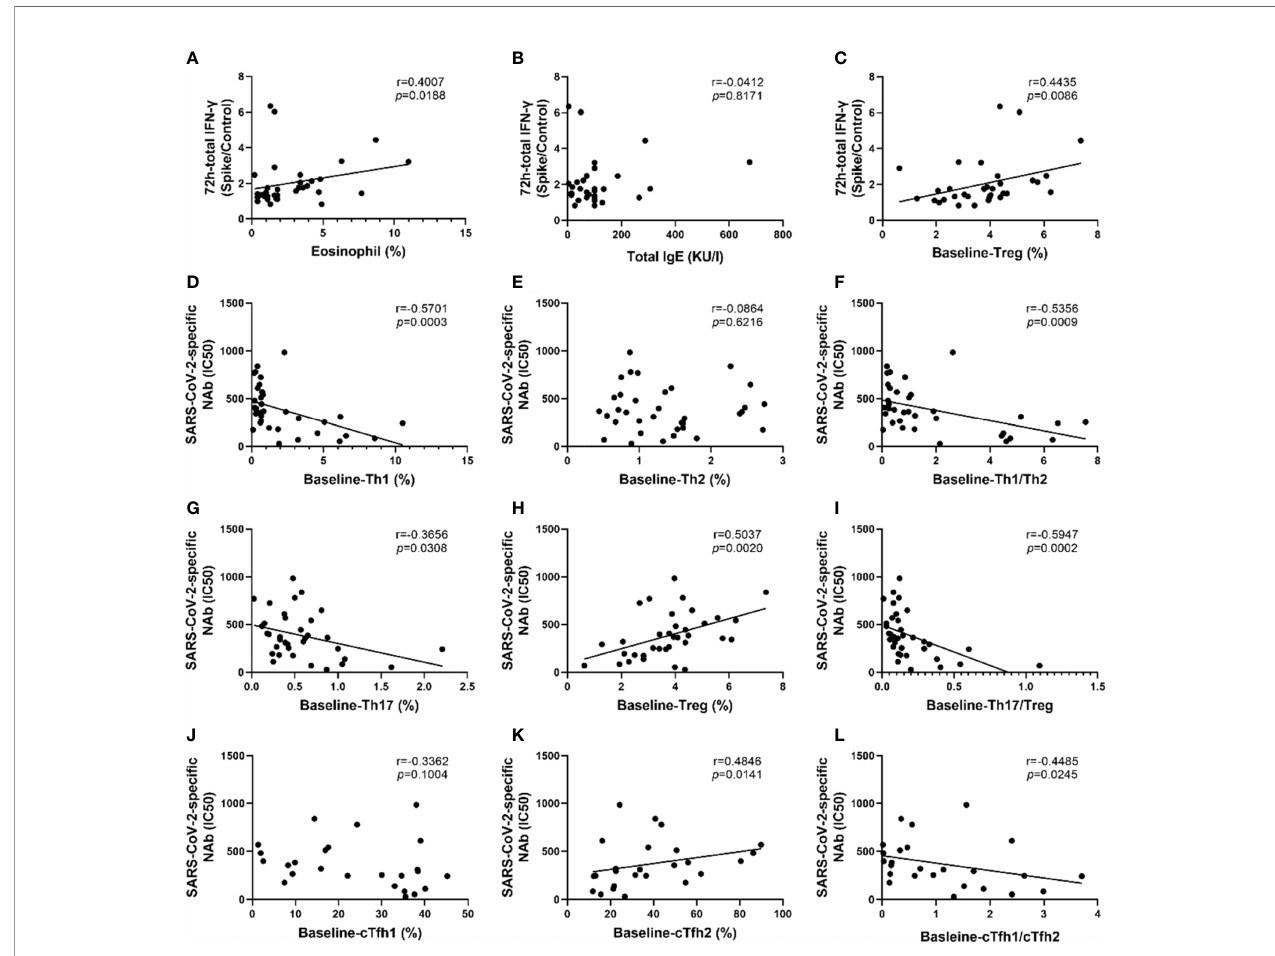
FIGURE 5 | SARS-CoV-2-speci fi c memory T cell responses and neutralizing antibodies were associated with T lymphocyte subsets and eosinophil proportions. (A – C) Correlation analysis of SARS-CoV-2 memory T cell response with eosinophils proportion, total IgE, and the percentage of Treg cells. (D – I) Correlation analysis of SARS-CoV-2-speci fi c NAbs with the proportions of Th1 cells, Th2 cells, Th17 cells, and Treg cells, the ratio of Th1/Th2 and Th17/Treg. (J – L) Correlation analysis of SARS-CoV-2 speci fi c NAbs with the proportions of cTfh1 cells, cTfh2 cells, the ratio of cTfh1/cTfh2. Each dot represents an individual subject. The black solid line of linear regression represents the overall trend. R and p value are calculated using Spearman ’ s